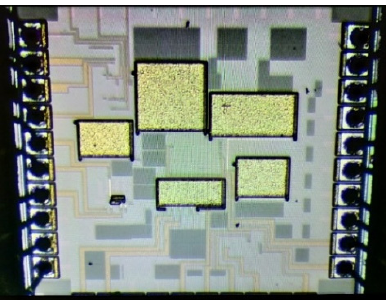
Figure 15. Chip fabricated in 130 nm BiCMOS technology.